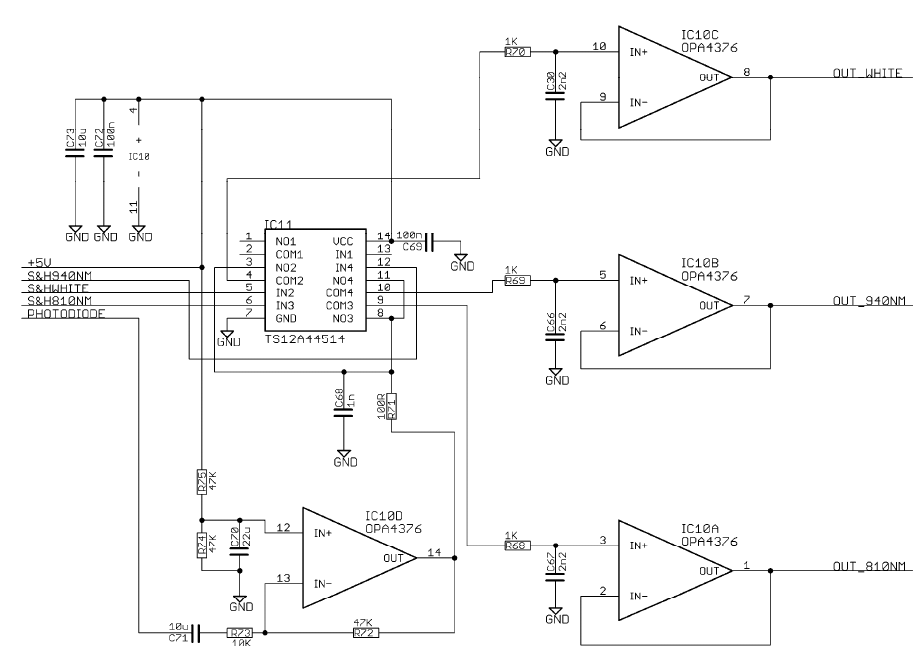
Figure A3. Demultiplexer. The demultiplexer receives the photodiode amplifier output and sends three dedicated analogue audio signals to the ADC.